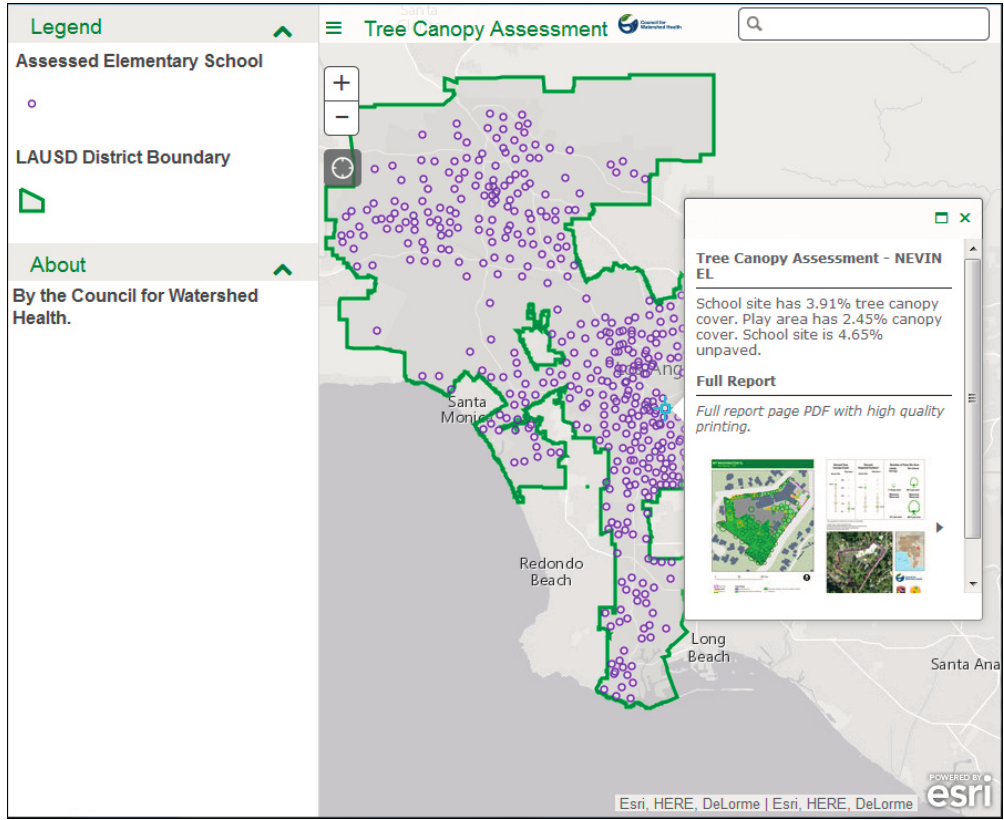
Figure 4. Website showing map layers, data, and report